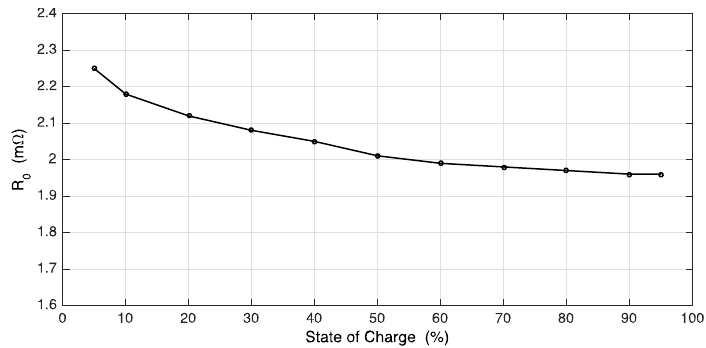
Figure 7. Battery cell internal resistance dependence on state of charge.